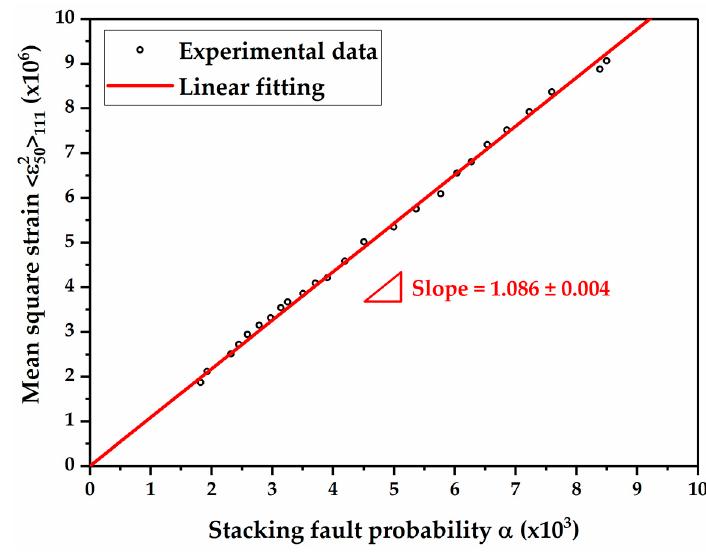
Figure 8. The plot of mean square strain vs. stacking fault probability in the Fe-17Mn-1.5Al-0.3C steel corresponding to various tensile strain levels.